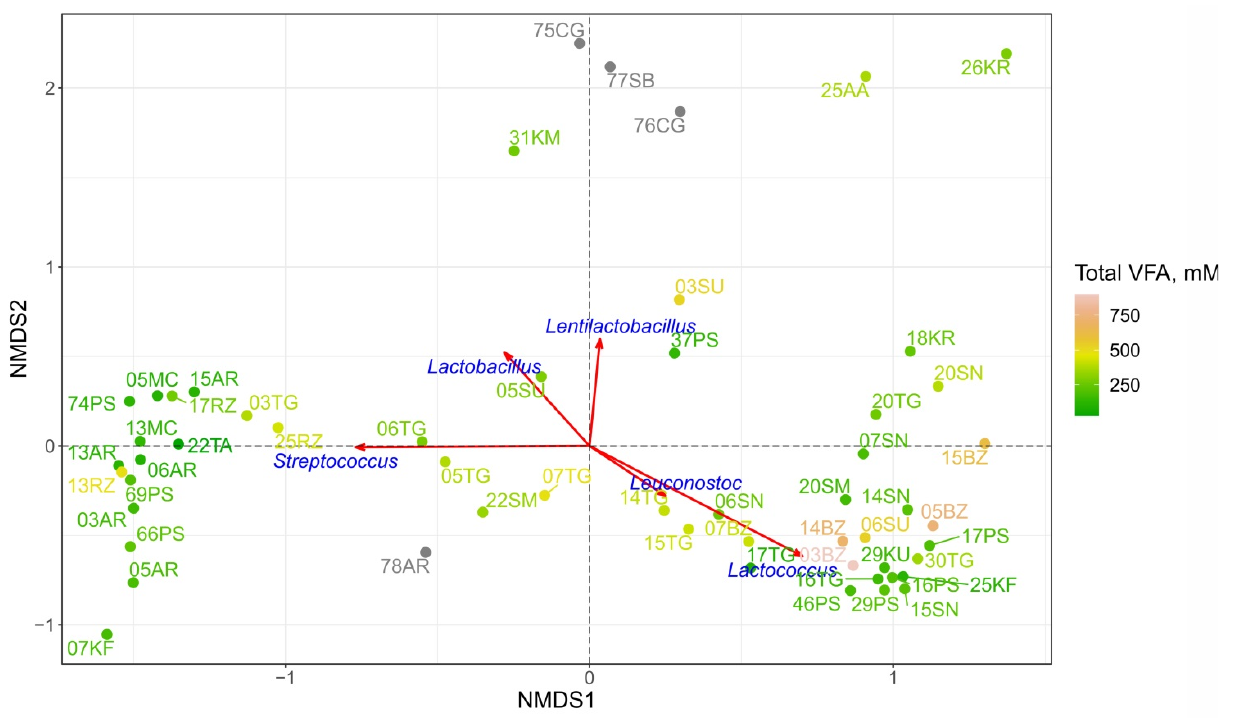
Figure 5. FMP microbiomes dissimilarity displayed by NMDS plots (stress value = 0.13). Color grading corresponds to the concentration of total VFA for each product. The same results for individual VFA are shown on Figure S2. For 4 samples colored in gray, the VFA concentration was not measured. Red vectors indicate the correlation of the dominant genera abundance with the axes of ordination and their statistical significance based on a permutation test (1000 permutations, p -value < 0.05), i.e., demonstrate the strength and direction (within the present coordinates) of influence of certain bacterial taxa on sample clustering.